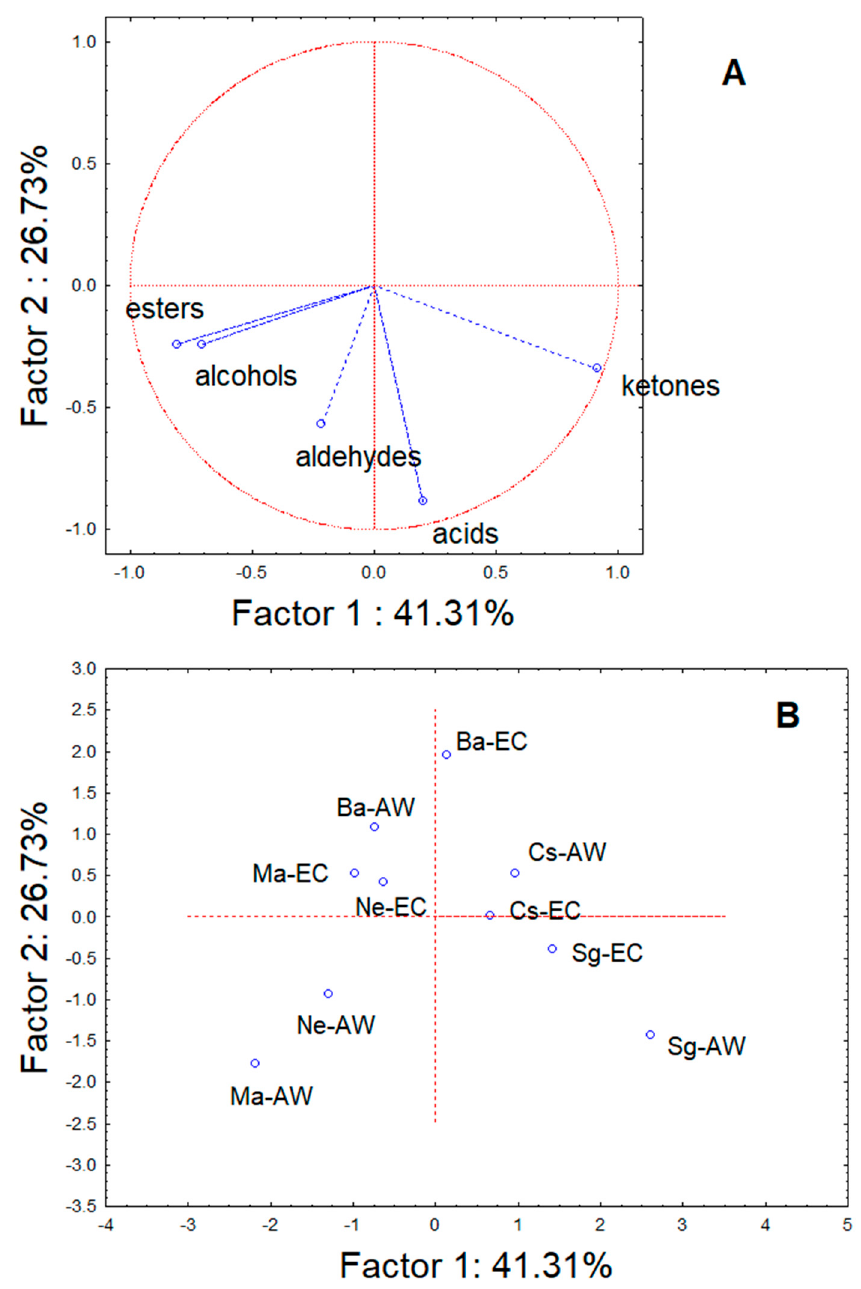
Figure 7. Principal component analysis run on the total amounts of esters, alcohols, acids, aldehydes, and ketones. ( A ) Variable projection; ( B ) case projection. Sg, Sangiovese; Ma, Magliocco; Ba, Barbera; Cs, Cabernet-Sauvignon; Ne, Negroamaro. EC, strain EC1118; AW, strain AWRI796.